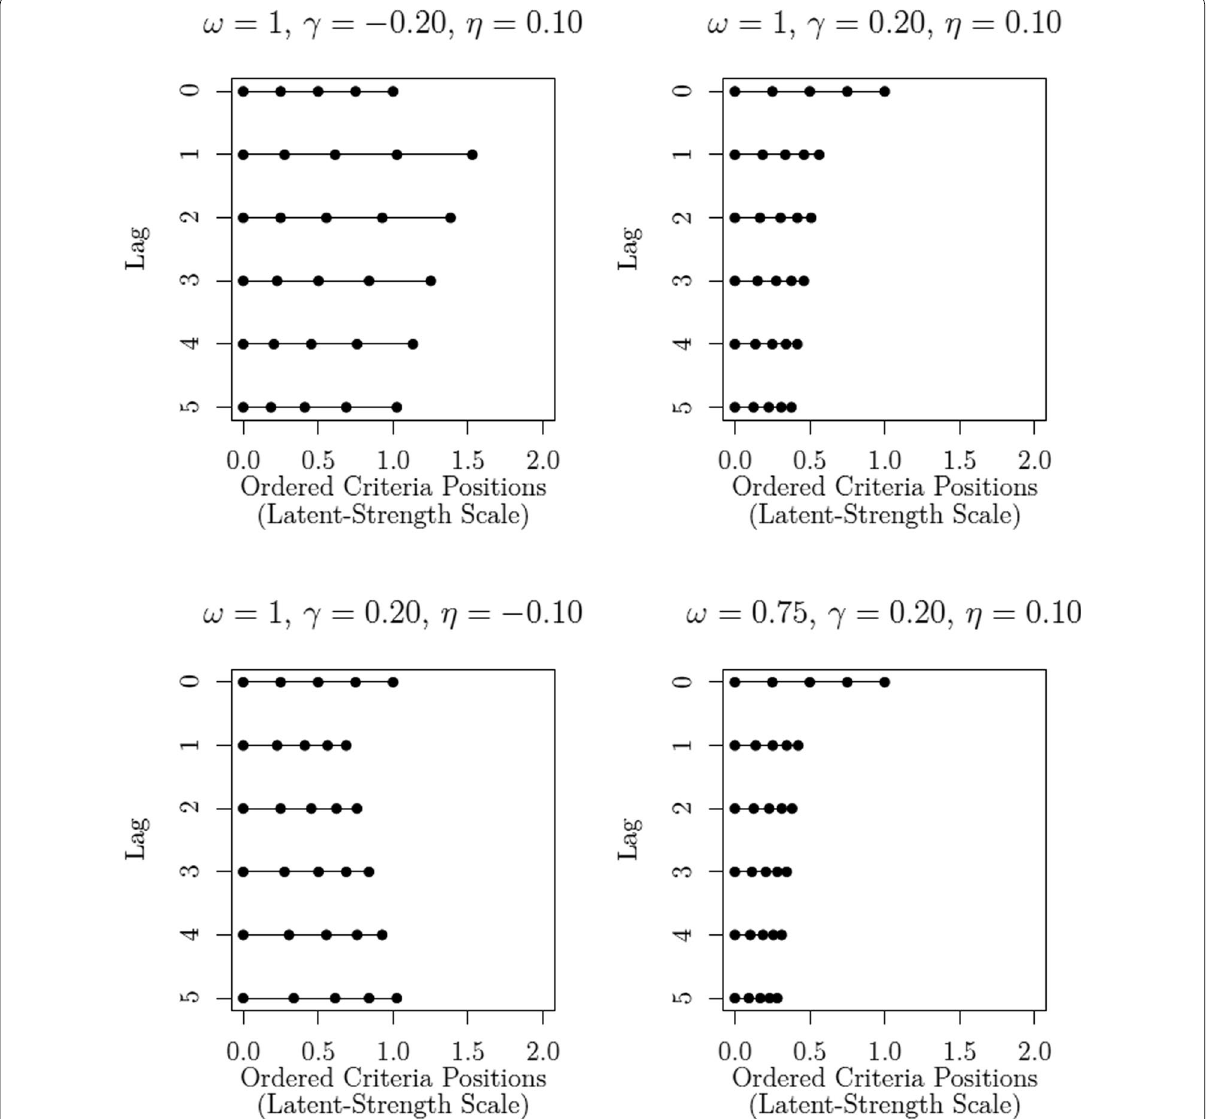
Fig. 8 Examples of the effect of previously encountering and rejecting the target on ordered confidence criteria τ i , which is established as a function of parameters ω , γ , and η and Lag = i − h . Lag = 0 denotes the value of the criteria when the target is encountered. For illustrative purposes, τ 0 remains fixed at 0 across lags and the contiguous confidence criteria in Lag = 0 are